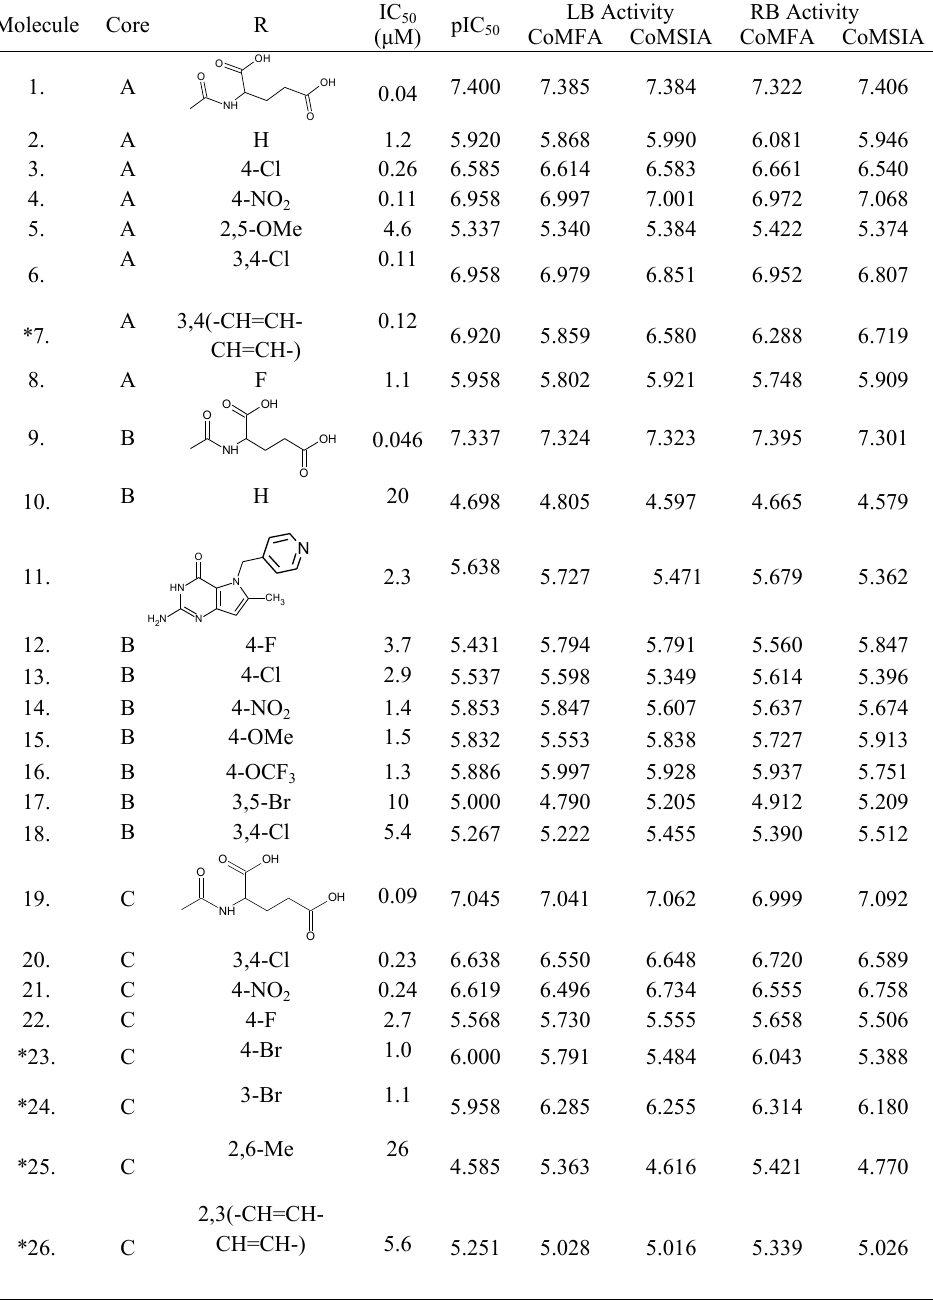
Table 1. Structures of the training and test set of molecules showing Experimental and Predicted